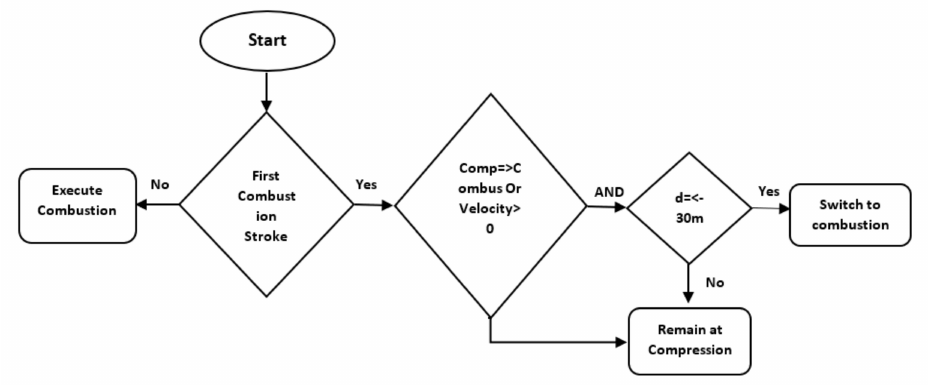
Figure 11. Conditions to allow switching of pressure profile from compression–expansion model to combustion